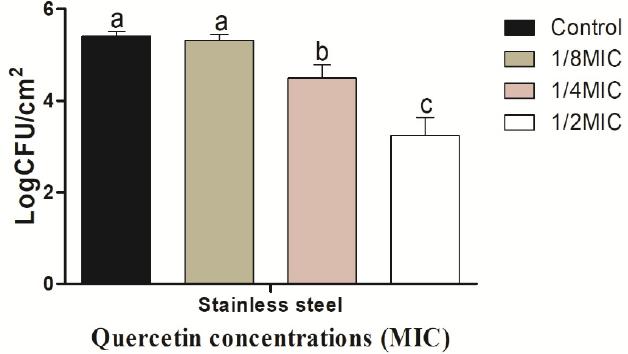
Figure 4. Inhibition of Vibrio parahaemolyticus biofilm formation (24 h) on stainless steel by sub-MICs of quercetin (µg/mL). Data are represented as mean ± SEM of three independent replicates. a–c Values with different letters differ significantly different by Duncan’s multiple-range test ( p < 0.05). As quercetin content increased, the biofilm-inhibiting impact grew as well. The V. CFU/cm 2 , respectively, at quercetin quantities of 1/8, 1/4, and 1/2 MIC. Comparing these values to the control and other MIC groups, they were significantly ( p < 0.05) suppressed